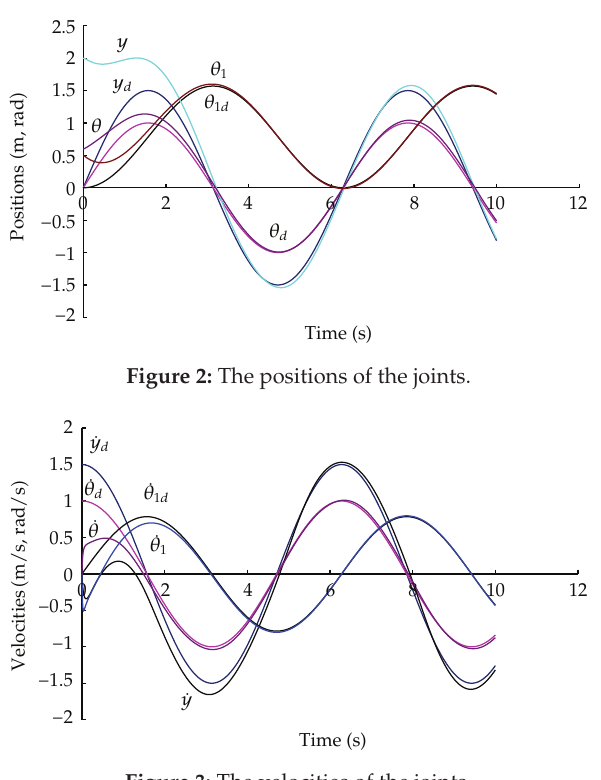
Figure 3: The velocities of the